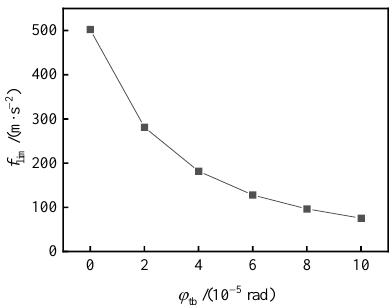
Figure 19. Overload limit versus the angular deviation of the axis.